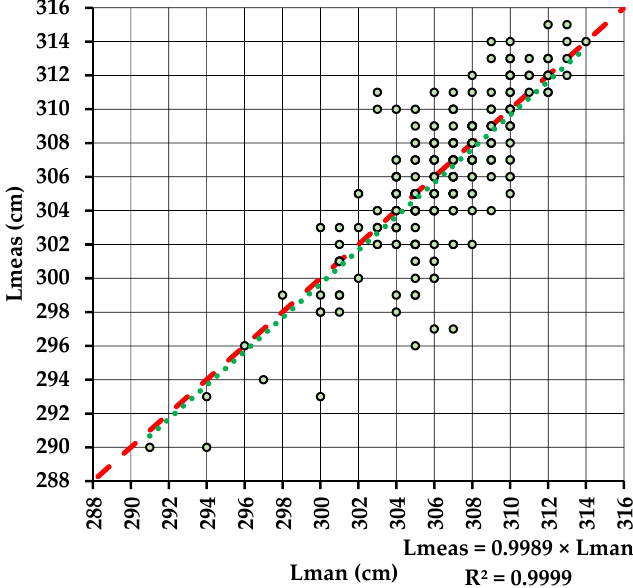
Figure 9. Relation between the lengths measured by the two methods (E1). Legend: red dashed line stands for perfect agreement and green dashed line stands for the dependence relation between Lmeas and Lman fitted by RTO.